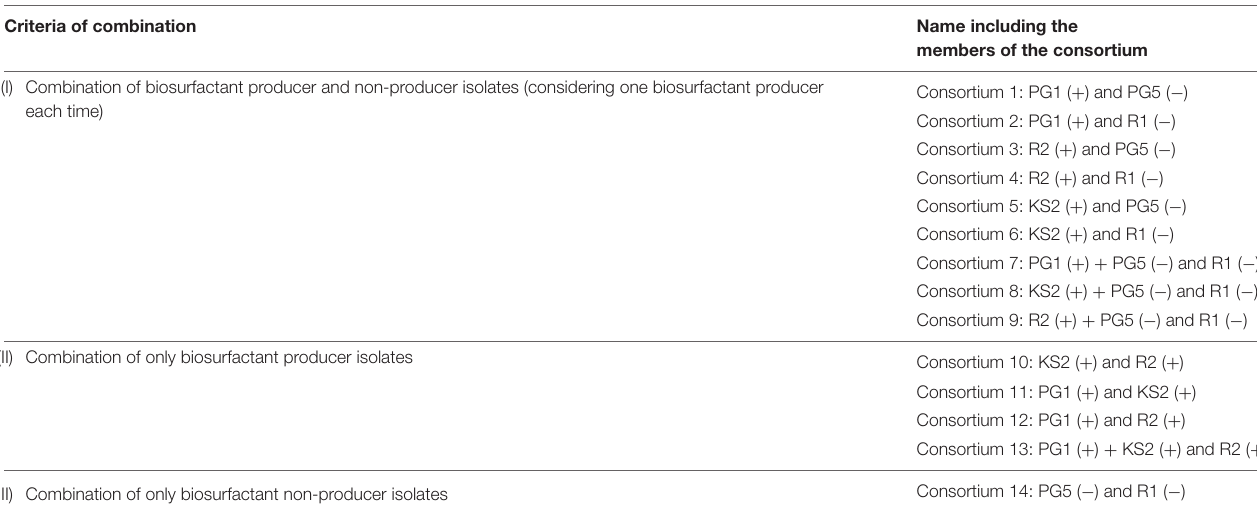
TABLE 2 | Table representing different criteria of combination for consortia development and various consortia included in different category. Criteria of combination